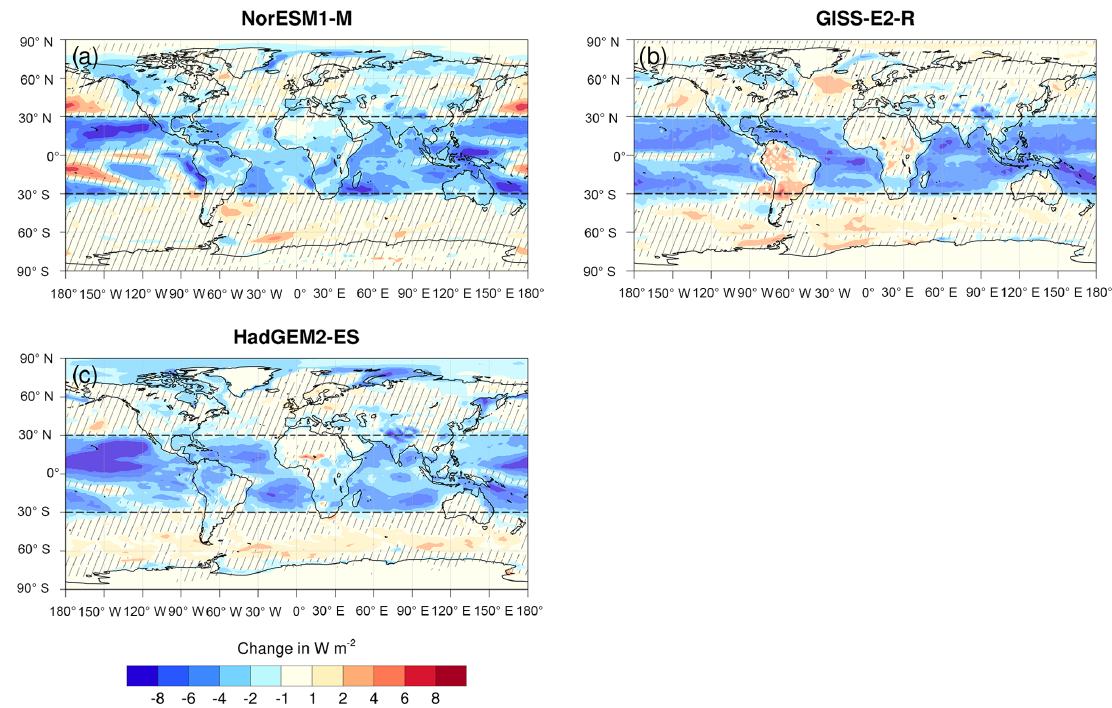
Figure 12. Mean change in net SW radiation (Wm − 2 ) at the TOA between G4sea-salt and RCP4.5 for the period 2035–2065 for (a) NorESM1-M, (b) GISS-E2-R, and (c) HadGEM2-ES. Hatching denotes areas where changes are not significant at the 95% confidence level (Student t test with respect to variance of annual mean